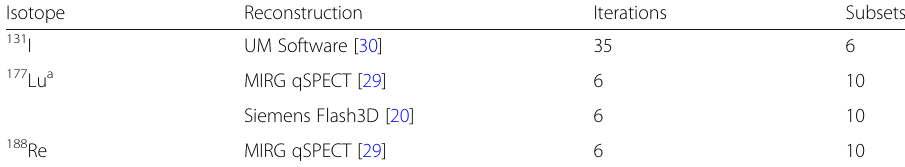
Table 5 Parameters used in the reconstructions of images from experimental and simulated tomographic data (experiments performed using configurations HS + CB, HS + HB and HC) Isotope Reconstruction Iterations